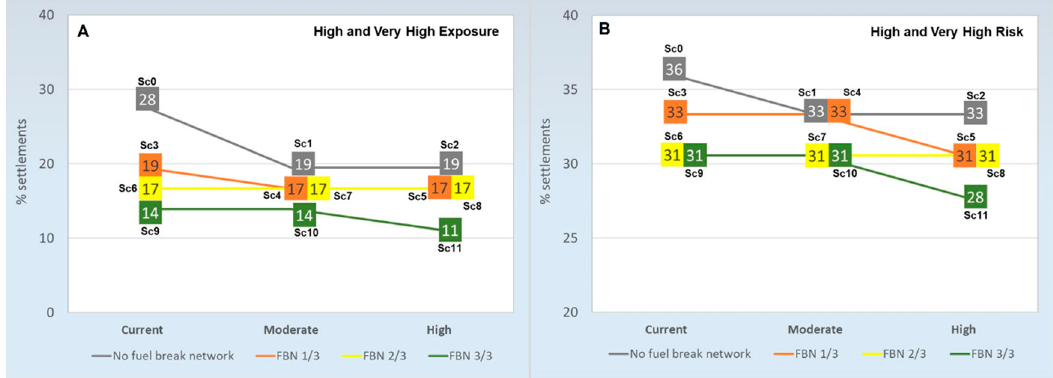
Figure 8. Percentage of settlements with high and very high exposure (A) and risk (B) in the different scenarios. In both A and B, the x-axis represents the three levels of forest management, and the coloured lines represent the fuel break network implementation with different priorities. A —Exposure, represents the combination of burn probability (hazard) with exposed elements; B —Risk, represents the combination of exposure and vulnerability (with coping